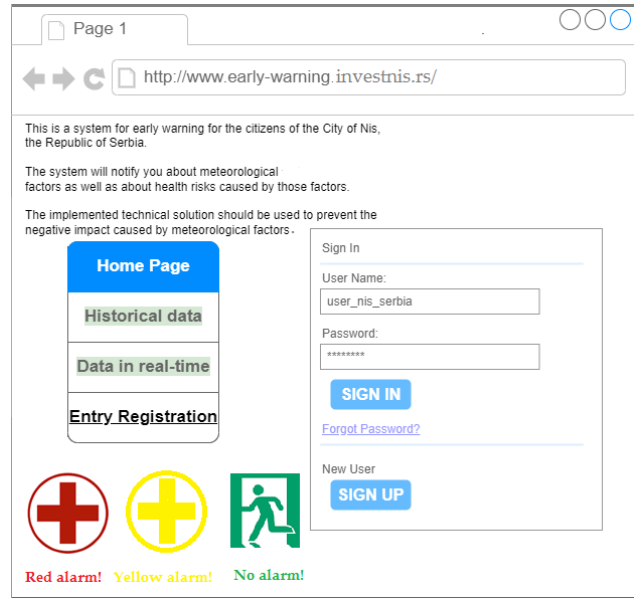
Figure 5. The mockup of web application for early warning for the citizens of Nis